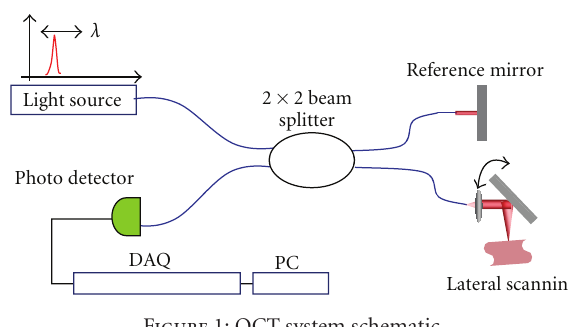
Figure 1: OCT system schematic.